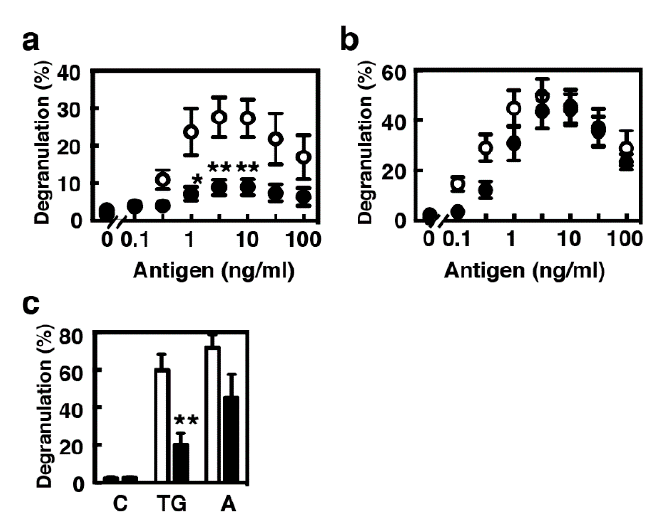
Figure 3. Comparison of the profiles of antigen-induced degranulation between BMMCs and MCs / IL-9. ( a , b ) BMMCs (open circles) or MCs / IL-9 (closed circles) were sensitized with ( a ) 10 ng / mL or ( b ) 1 µ g / mL anti-TNP IgE (clone IgE-3) for 3 h at 37 ◦ C. The cells were twice washed and stimulated with the indicated concentrations of the antigen (TNP-conjugated BSA). The levels of degranulation were determined by measuring the enzymatic activity of β -hexosaminidase. Values are presented as the means ± SEM ( n = 4). Multiple comparisons were performed using two-way ANOVA with the Sidak test. Values with * p < 0.05 and ** p < 0.01 are regarded as significant. ( c ) BMMCs (open columns) or MCs / IL-9 (closed columns) were stimulated without (C, vehicle) or with 300 nM thapsigargin (TG) or 1 µ M A23187 (A). The levels of degranulation were determined by measuring the enzymatic activity of β -hexosaminidase. Values are presented as the means ± SEM ( n = 4). Statistical analysis was performed using Student’s t -test. A value with ** p < 0.01 is regarded as significant.